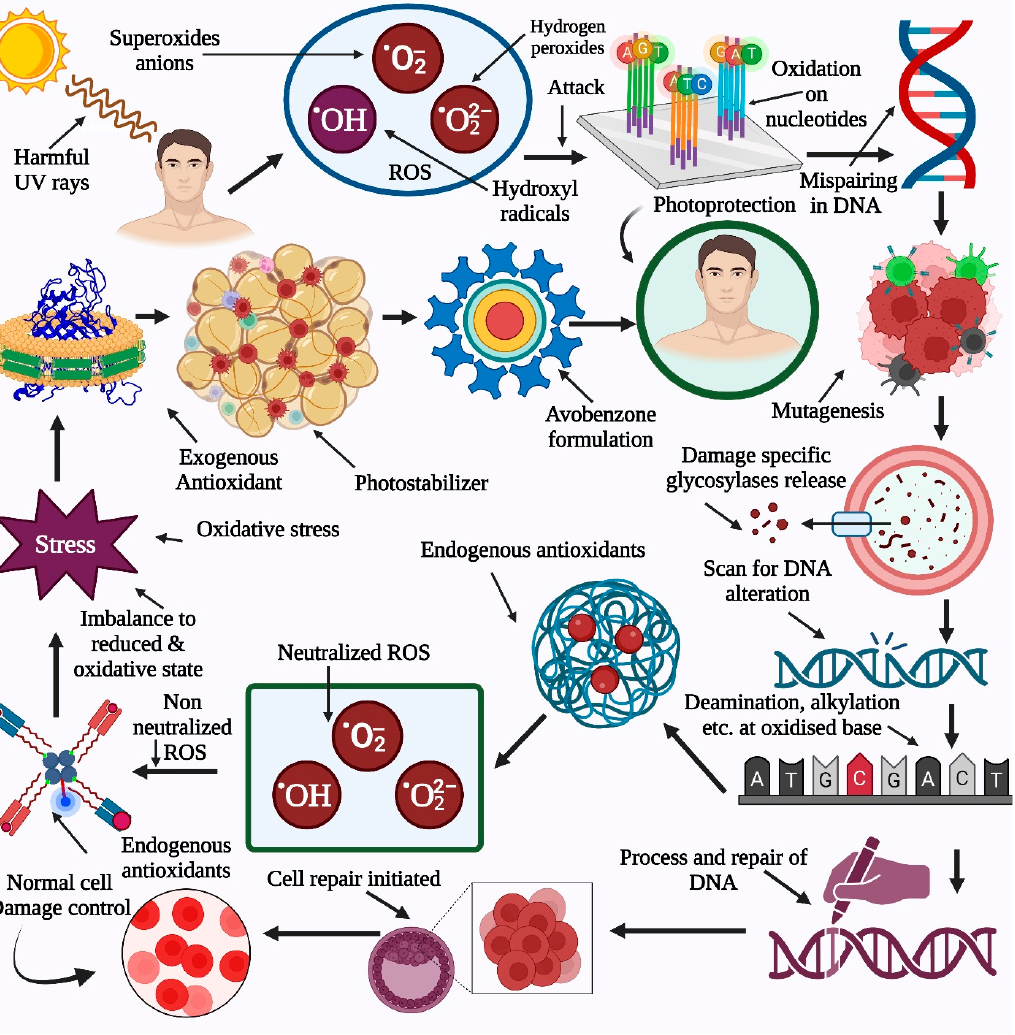
Figure 6. Mechanism of reactive oxygen species interactions with the body to induce skin cancer and other side effects. Several antioxidants are used to counter damage, such as DNA damage, apoptosis, and cell proliferation, induced by ROS. Different process parameters, including metabolic reactions in peroxisomes, oxidative phosphorylation in mitochondria and enzymatic reactions, play pivotal roles in the generation of ROS. Endogenous antioxidants are implemented to stabilize reactive oxygen species. In the absence of their interference, the enhanced oxidative stress will form several harmful effects on the body that need to be addressed by exogenous antioxidant